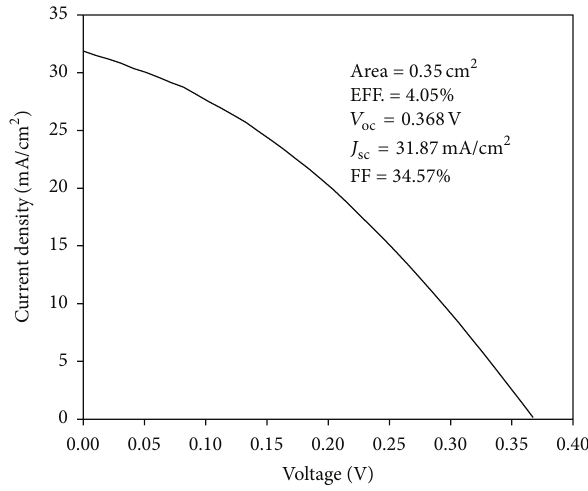
Figure 8: I - V characteristics of CIGS thin-film solar cell under